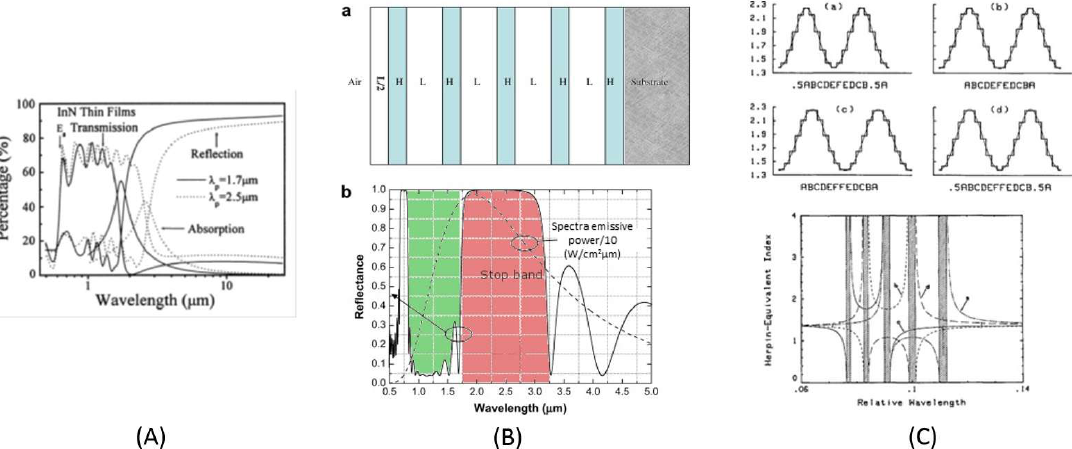
Fig. 9. Types of filters used in STPV systems. (A) The reflection of an InN-based plasma filter, the plasma wavelengths of 1.7 and 2.5 µm corresponding to the band gap of GaSb and GaInAsSb PV cells, respectively. Eg represents the band gap of InN. Panel (A) adapted with per- mission from [90]. © 2002, AIP Publishing LLC. (B) An example of a 1D ten-layer PhC (a), described as L /2 H ( LH ) 4 , where L and H represent quarter-wavelength thick layers of SiO2 (low refractive index) and Si (high refractive index), respectively, while L/2 represents half-quarter- wavelength thick layer of SiO 2 and the corresponding normal incident reflectance of 1D Si/SiO 2 L /2 H ( LH ) 4 PhC and the spectra emissive power of a blackbody radiator at 1500 K (b). Adapted from Mao and Ye [91]. (C) (Top) Four ways of approximating a rugate filter by a stepped index design. The continuous curves correspond to an index profile in which the log of the index is sinusoidal. (Bottom) Herpin-equivalent (effective medium) index of the four six-material designs in the vicinity of the stopbands. The curves are labeled with letters correspond- ing to their representation in the top figure. The stopbands themselves are shaded. Panel (C) adapted with permission from [94]. © 1989 Optical Society of